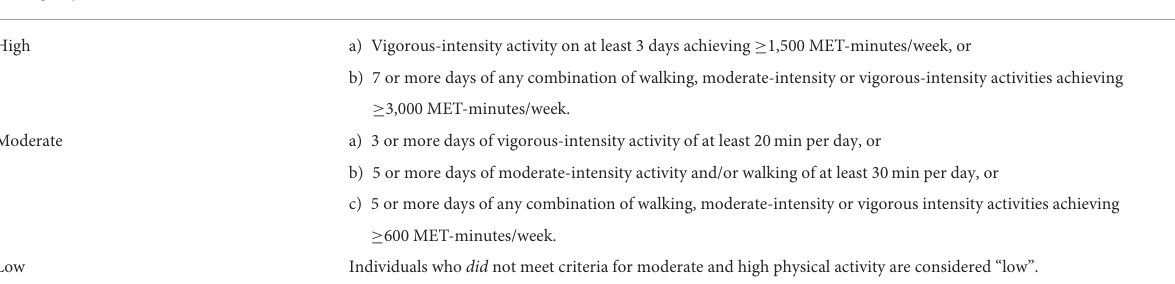
TABLE 1 Categorization of physical activity